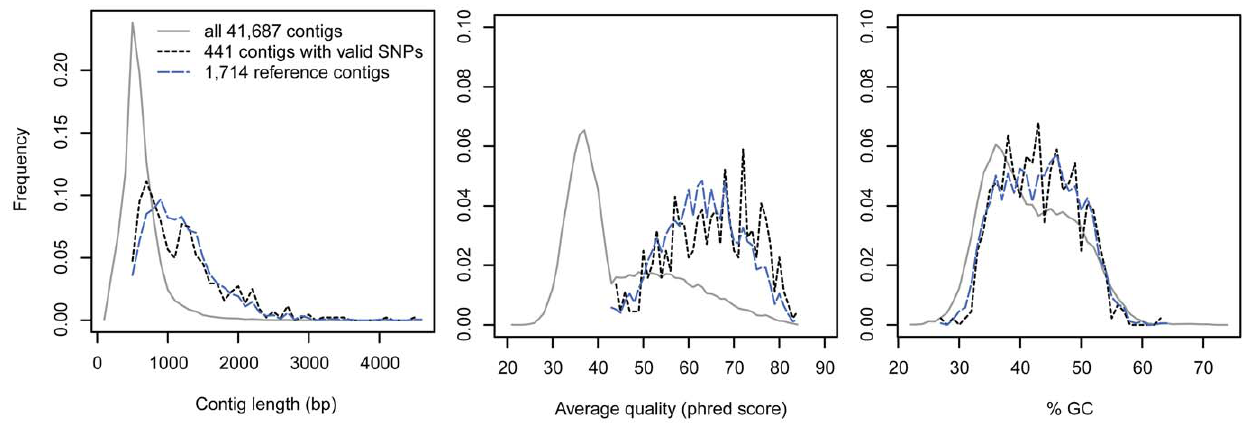
Figure 2. Effect of data quality filtering on contig length, average quality, and GC content. Solid line: all contigs after removal of singletons and repetitive regions; black dashed line: contigs with high-quality SNPs; blue dashed line: reference contigs.